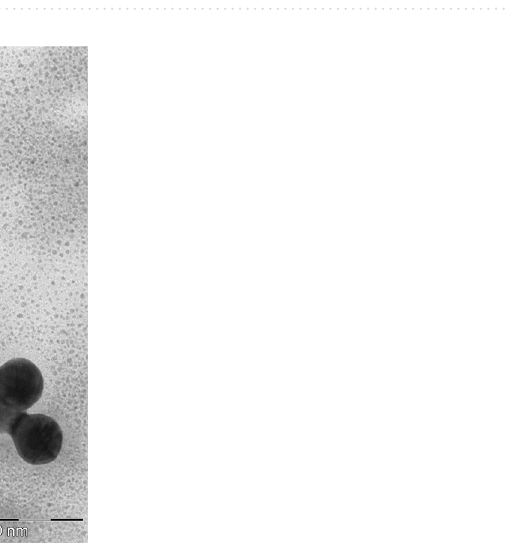
Figure 11. The coagulating effect of salts on negative Se NPs sol: ( a ) NaCl ; ( b ) Na 2 SO 4 ; ( c ) Na 3 PO 4 ; ( d ) BaCl 2 ; ( e ) FeCl